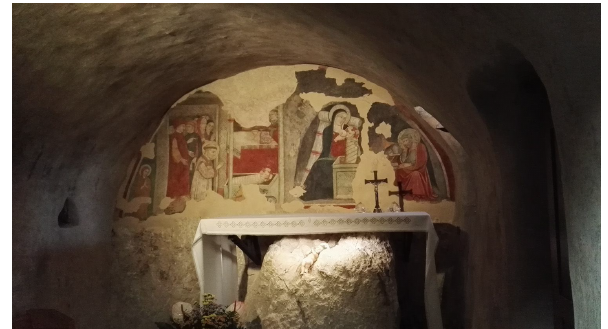
Figure 7. Limestone grotto at the monastery at Greccio, the site of the first nativity scene organized by St. Francis for Christmas in 1223. The limestone outcrop was the original altar before another was placed above it when the Pope visited. The 14th century fres- coes depict the original nativity scene. Photo credit: Ann C. Piz- zorusso.